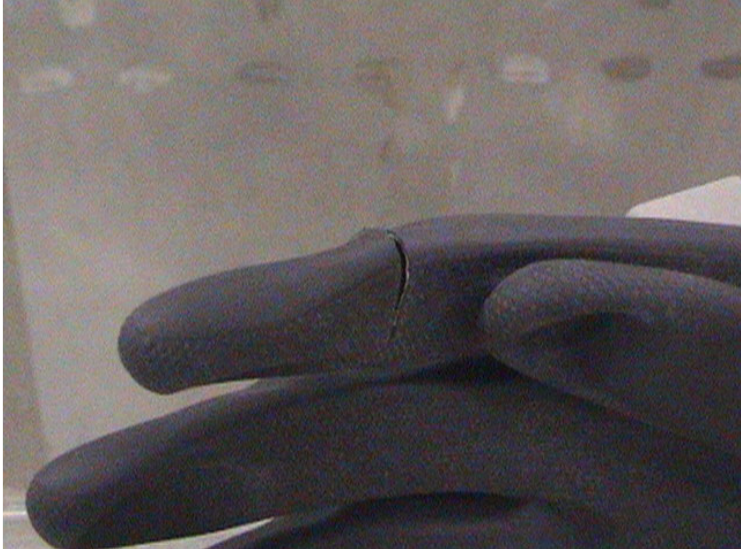
Figure 3. An example of the cut made in the glove of suits 3 and